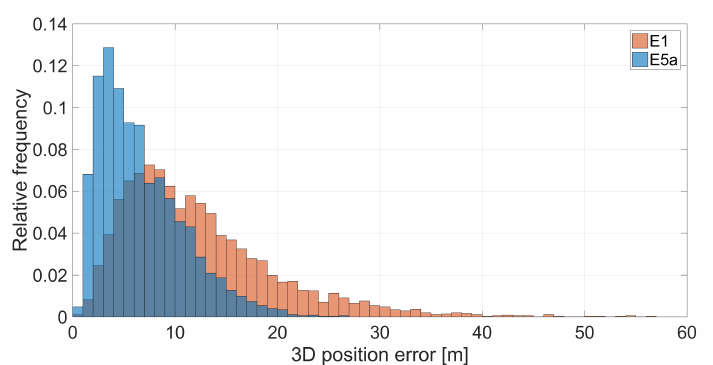
Figure 15. Three-dimensional coordinate error histogram for Galileo single point positioning of Xiaomi Mi 9. The results achieved with with E1 code observations are represented in red while those obtained with E5a ones are represented in blue. Each bin is 1 m wide.